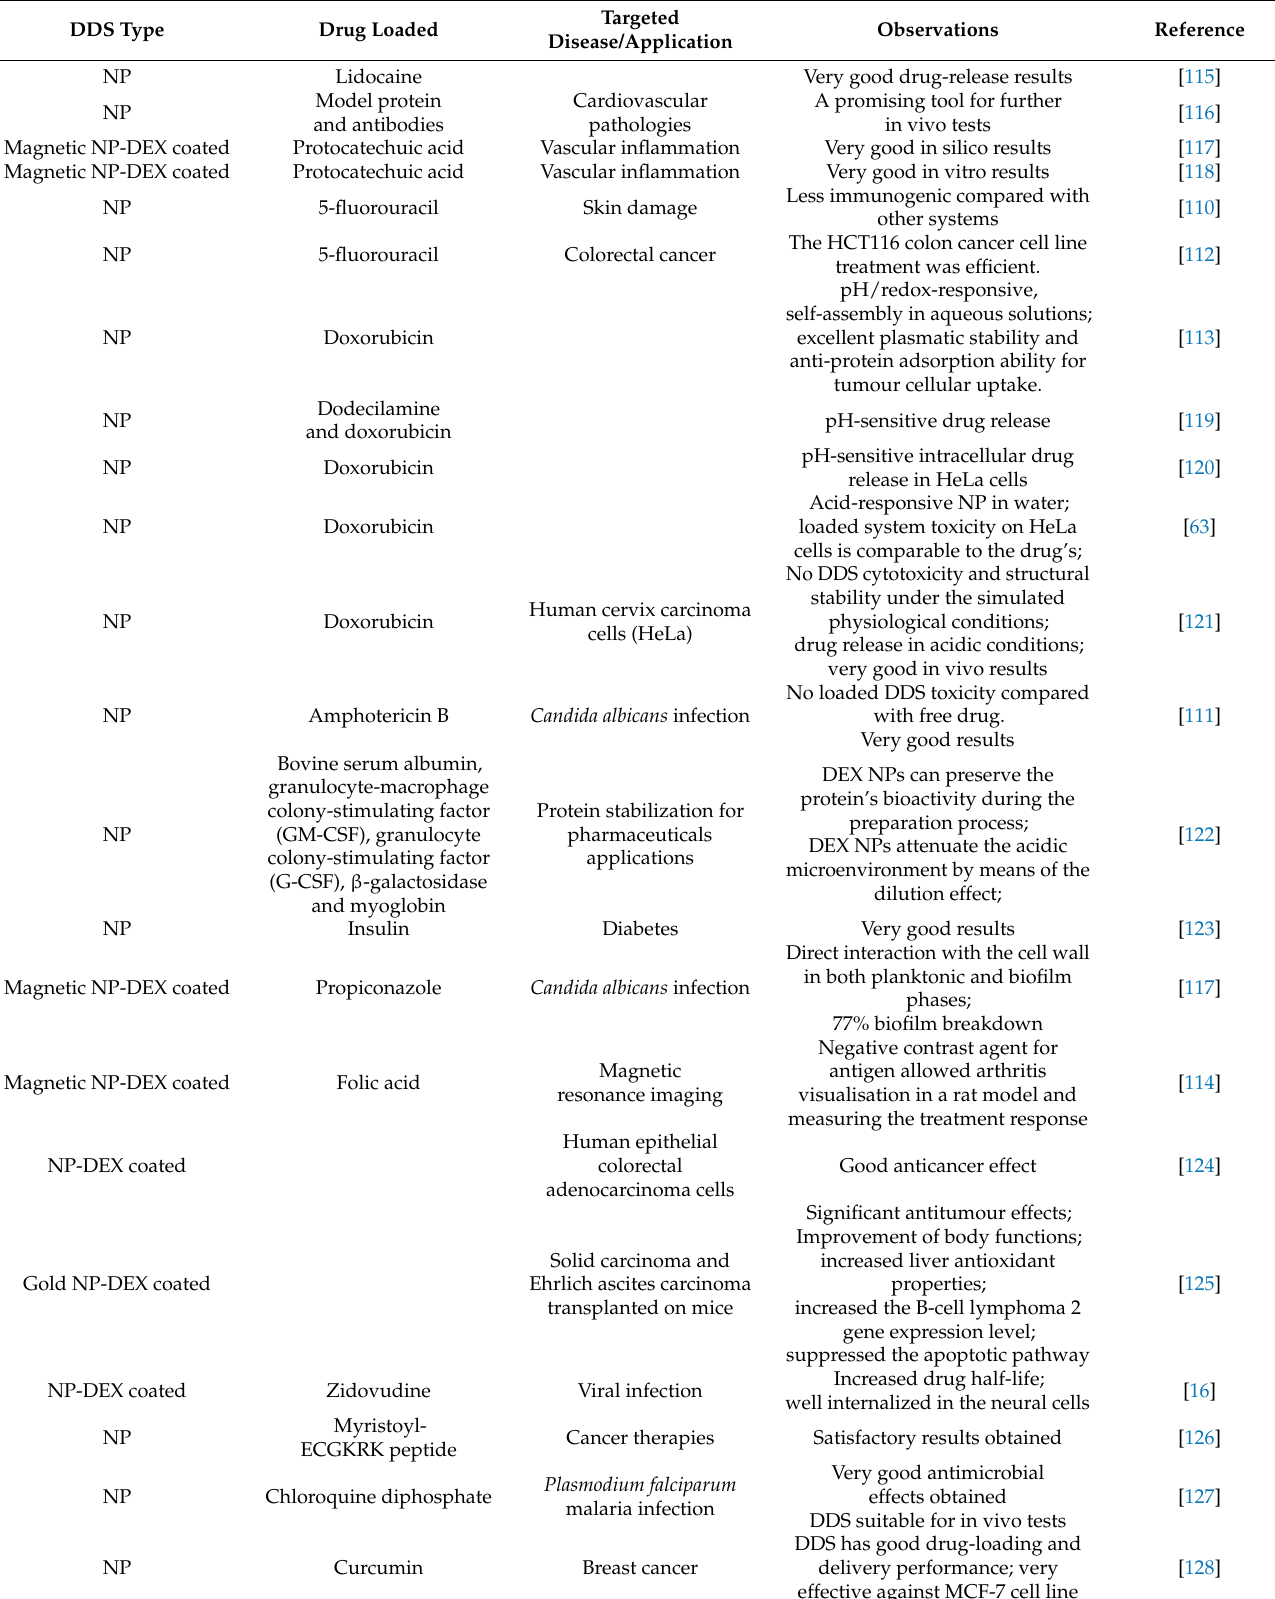
Table 3. DEX-based NPs developed for drug delivery in different